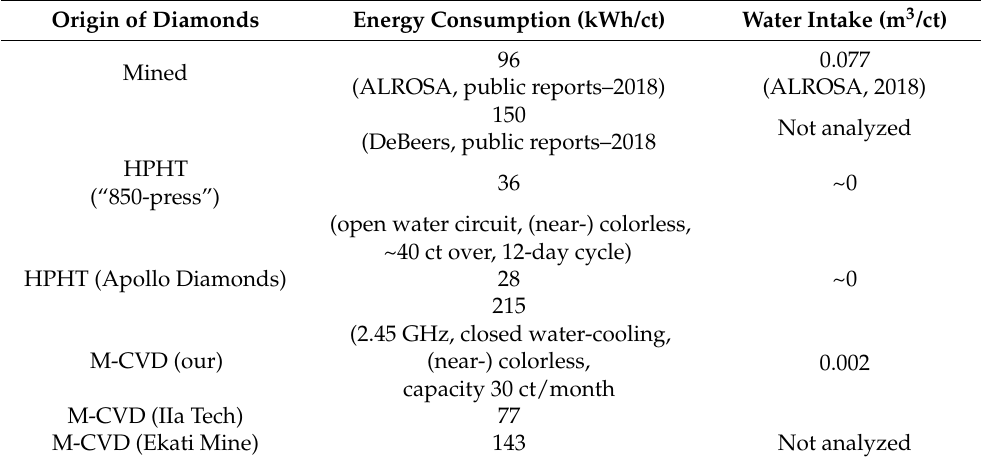
Table 4. Respective average energy and water consumption per one carat of mined (ALROSA, DeBeers), and manufactured (HPHT and M-CVD) diamonds. Origin of Diamonds Energy Consumption (kWh/ct)